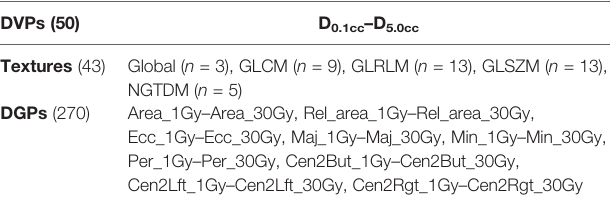
TABLE 1 | Extracted dosimetric features.